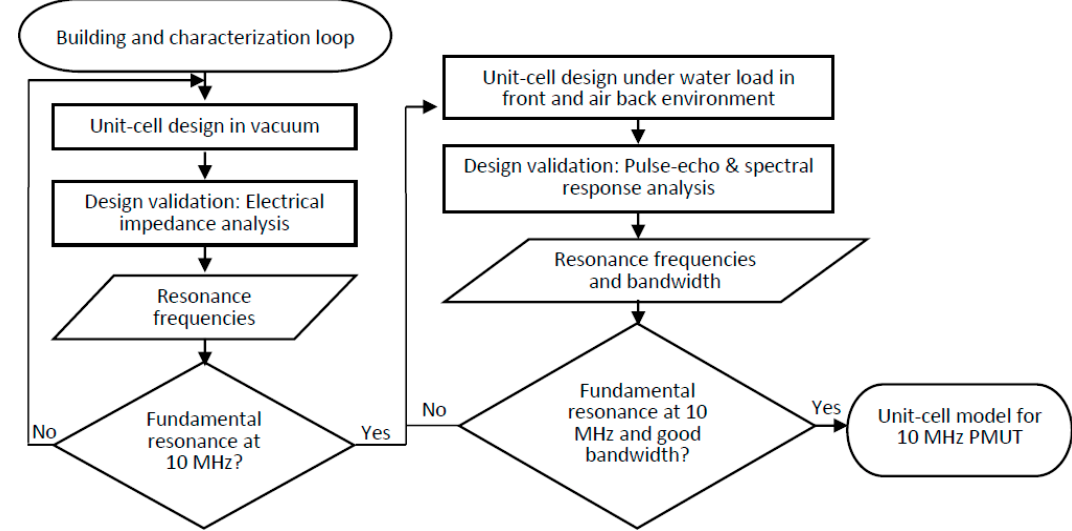
Figure1. Building, characterizationandvalidationloopsforthepiezoelectricmicromachinedultrasound Figure 1. Building, characterization and validation loops for the piezoelectric micromachined transducers (PMUT) unit-cell ultrasound transducers (PMUT) unit-cell design.